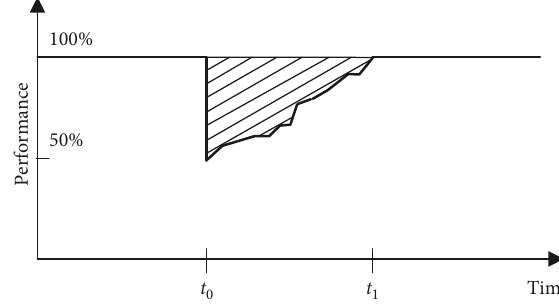
Figure 1: The resilience triangle (extracted from [29]).